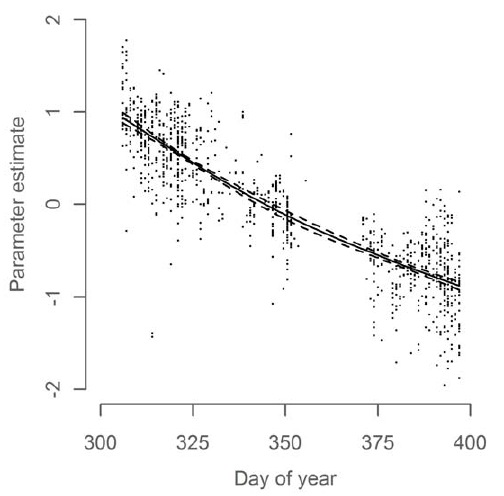
Figure 4. CSE parameter in the temperature model. Parameter estimate (solid line) with 95% confidence interval (dashed lines) and partial residuals (dots) relative to mean predicted value.